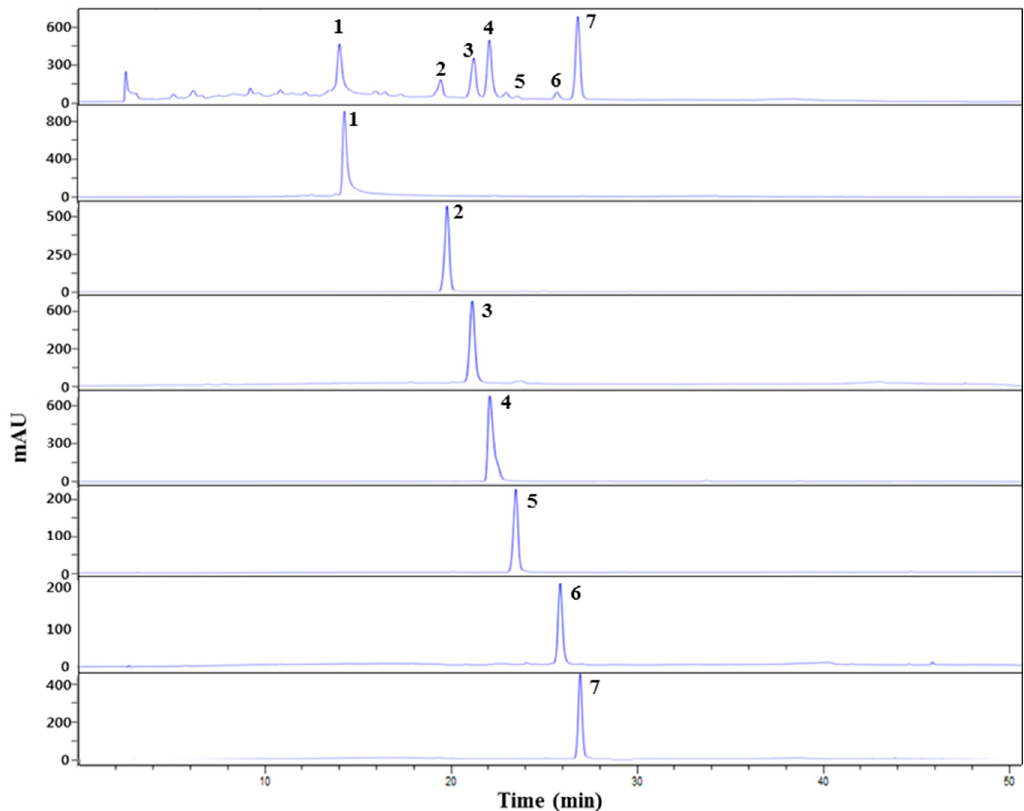
Figure 2. HPLC chromatogram of the compounds isolated from the n -BuOH fraction of A. pilosa Ledeb. at 254 nm; Peak 1: agrimoniin; Peak 2: rutin; Peak 3: luteolin-7- O -glucoside; Peak 4: luteolin-7- O -glucuronide; Peak 5: quercitrin; Peak 6: apigenin-7- O -glucoside; Peak 7: apigenin-7- O